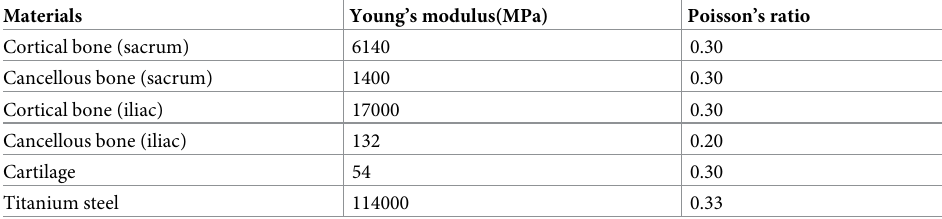
Table 1. Material properties of each part of the skeleton model [17–19]. Materials